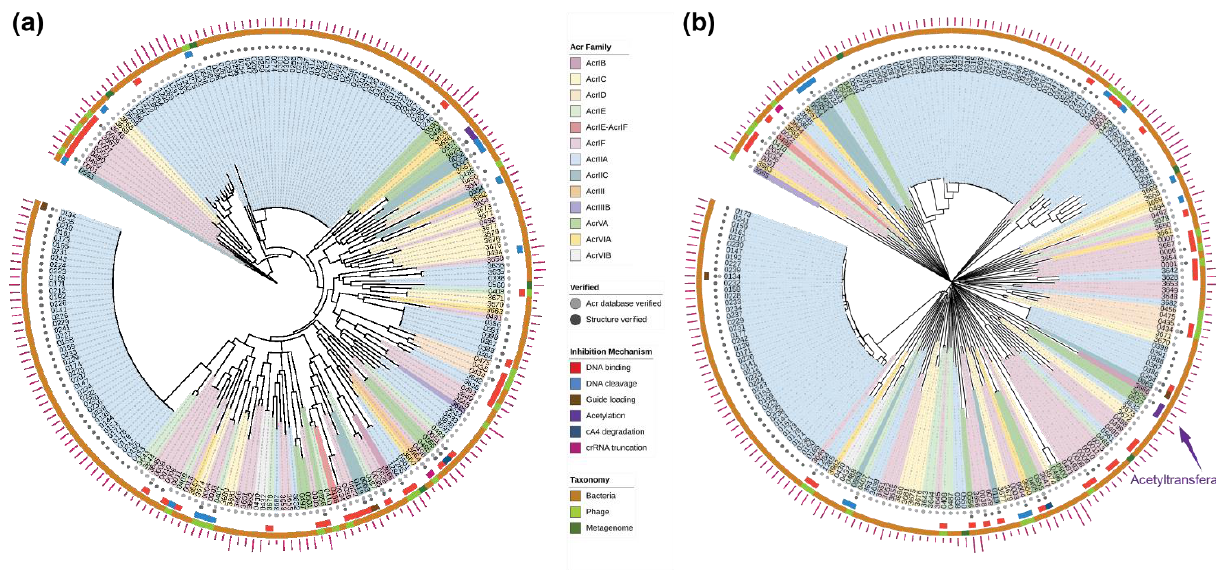
Figure 3. Evolutionary trees of anti-CRISPR proteins (numbered according to Anti-CRISPRdb [27]). ( a ) The phylogenetic tree of anti-CRISPR proteins reconstructed using sequence-based methods (Set A + Set B; n = 207). ( b ) The structural tree of anti-CRISPR proteins reconstructed using structure-based methods (Set A + Set B; n = 207). The clades of the two evolutionary trees were coloured by the Acr Family. The inner to outer rings display the Acr verification status, structural verification status, inhibition mechanism and source organism taxonomy. The outer magenta bars represent the genetic sequence length of each protein.